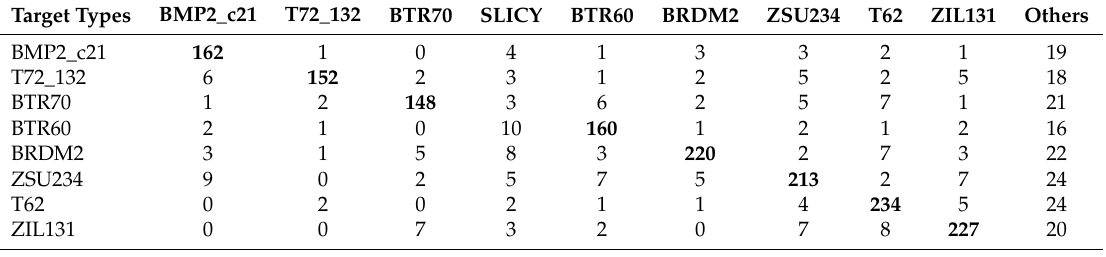
Table 4. Test results of different data domain HRRP sequence in the MIBL-softmax